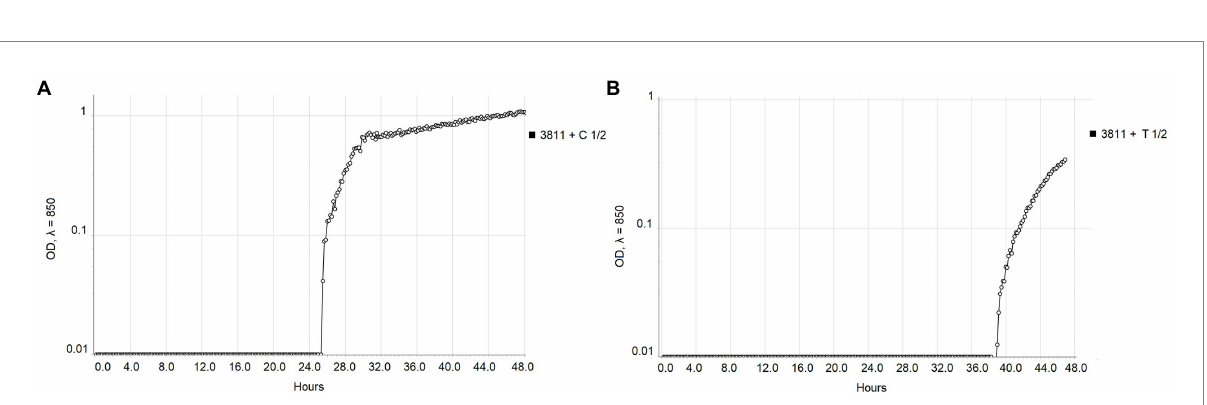
FIGURE 3 Comparison of the growth of Xanthomonas campestris pv. campestris strain WHRI 3811 treated with ½ MIC values of (A) carvacrol and (B) thymol measured by Cell Growth Logger (OD 850 , 48 h period, log 10 scale).